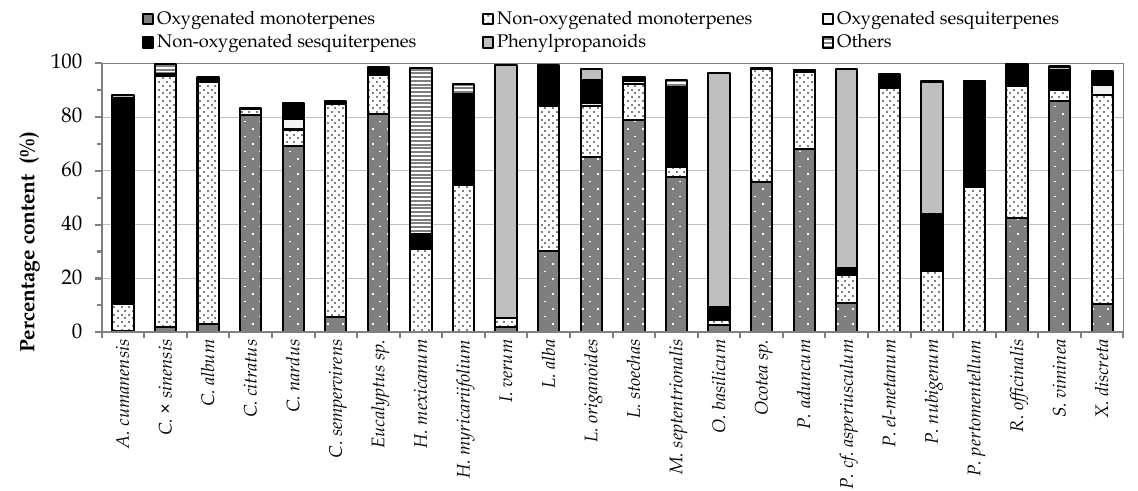
Figure 3. Content percentages of the main chemical classes of components in the 24 active EOs. Phenylpropanoid type oils represented 16.7% of the total oils, which contained be- tween 52.7 and 94.1% of this type of constituents. The oils belonging to this group were